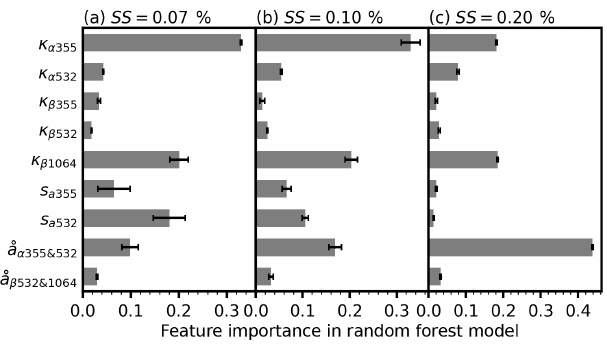
Figure 5. Importance of each feature (input parameter) output by the random forest model for predicting optically related CCN ac- tivation ratios at supersaturations of (a) 0.07%, (b) 0.10%, and (c) 0.20%. The values of feature importance indicate the decrease in impurity for each feature. The length of the bar represents the mean values among all trees and the error bars give the standard